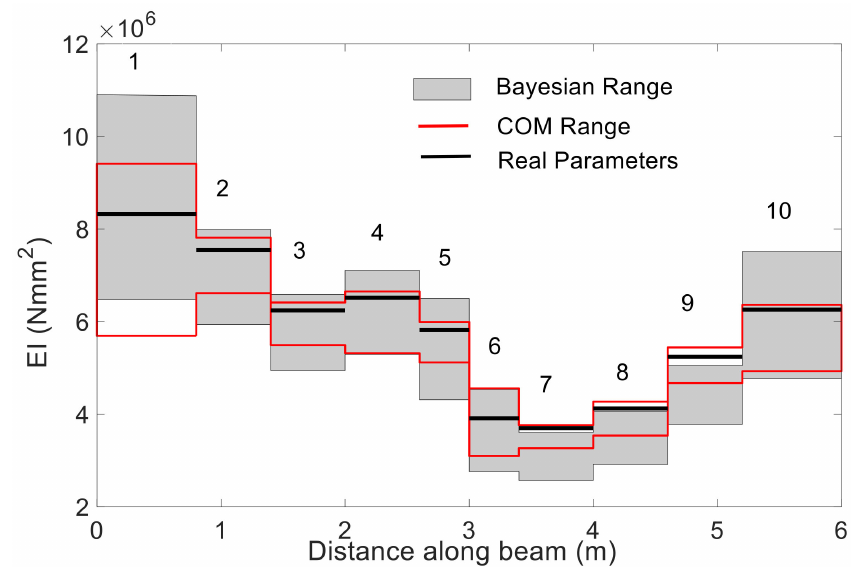
Figure 15. The stiffness range associated with the 99% confidence interval along the beam (the grey shadow represents the result by Bayesian analysis given in [4], the red line represents the range obtained by COM).